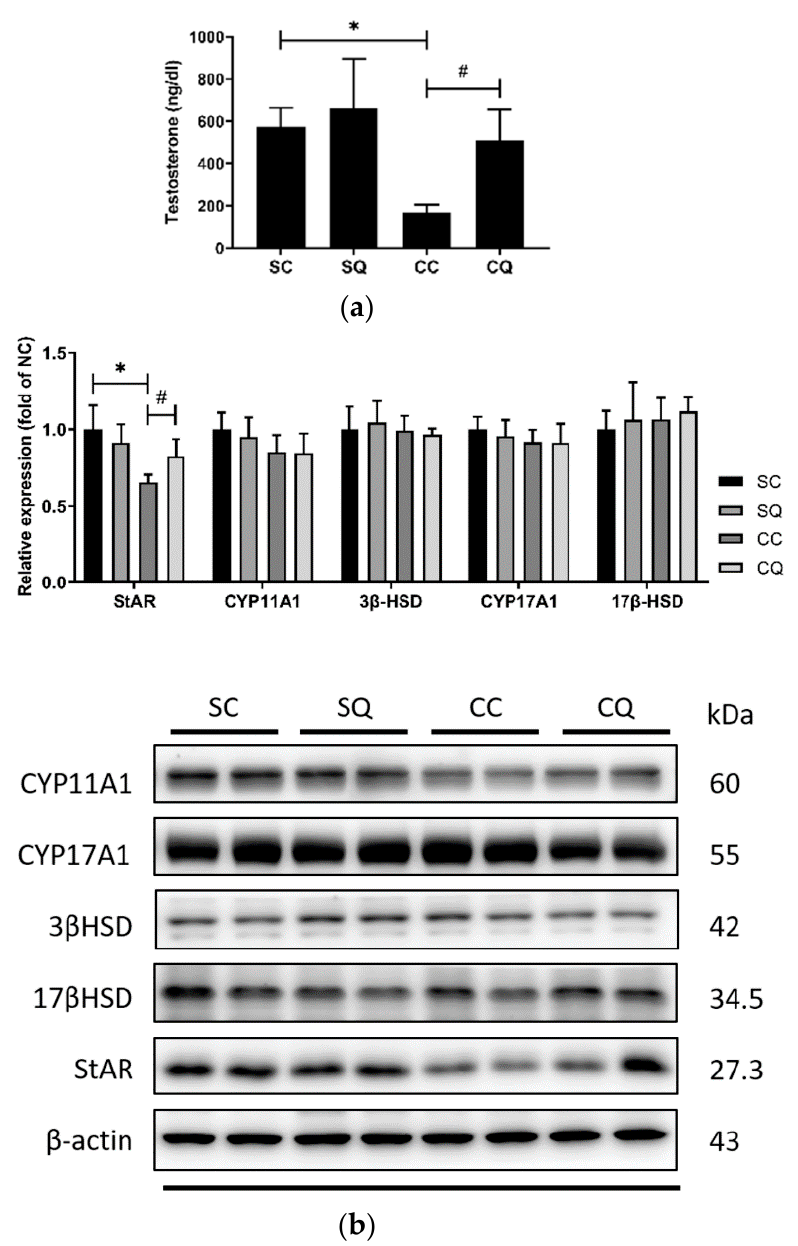
Figure 5. ( a ) Serum testosterone level and ( b ) protein expression of testosterone-biosynthesis enzymes (StAR, CYP11A1, 3 β -HSD, CYP17A1 and 17 β -HSD) in the sham surgery and CKD surgery mice treated with vehicle (corn oil) or CoQ10. SC: sham surgery mice with vehicle; SQ: sham surgery mice with CoQ10; CC: CKD surgery mice with vehicle; CQ: CKD surgery mice with CoQ10. Data are expressed as the mean ± SD ( n = 5–6 per group). * p < 0.05 denotes a significant difference between the sham surgery and CKD surgery groups (SC vs. CC and SQ vs. CQ); # p < 0.05 denotes a significant difference between the vehicle treatment and CoQ10 treatment groups (SC vs. SQ and CC vs. CQ). CoQ10, coenzyme Q10.